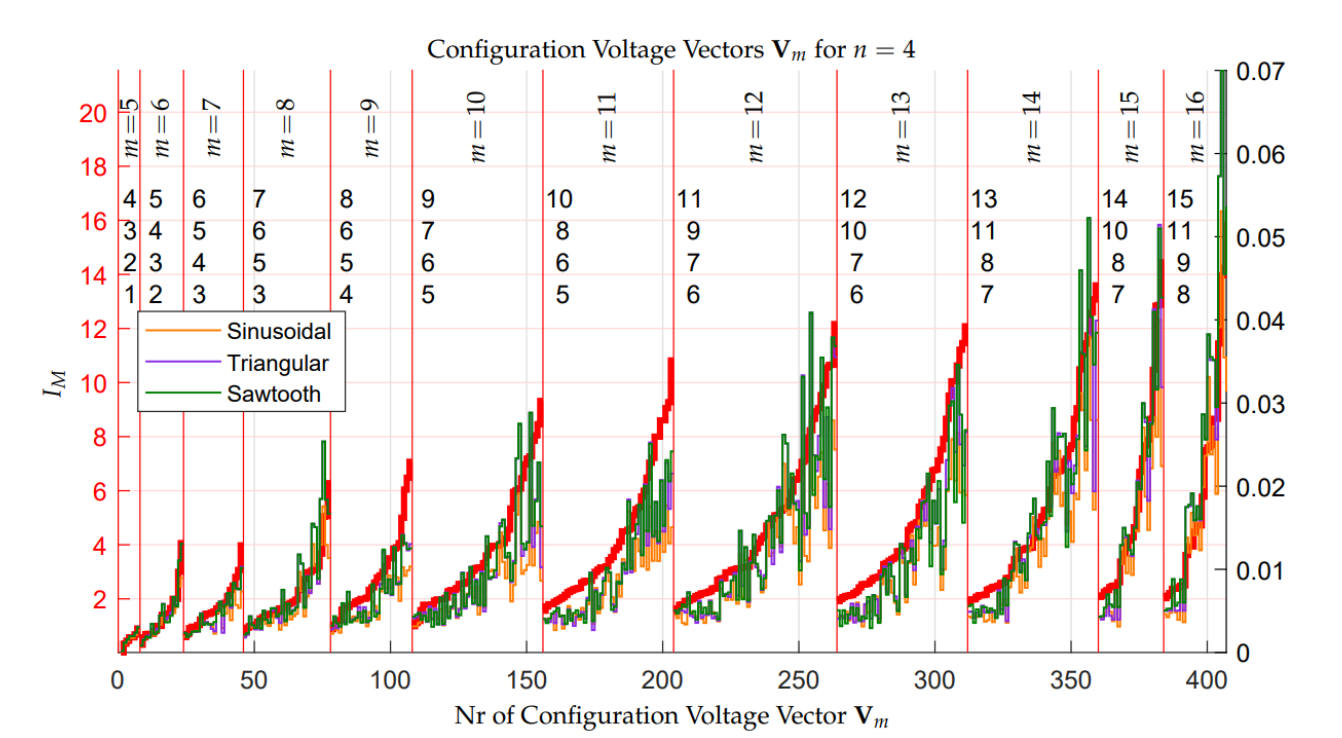
Figure 21. Comparison between the Divergence Index I M and metric max ( ∆ V ) , computed from simulation using three different ˜ V d signals, for the Configuration Voltage Vectors V m in the case n =